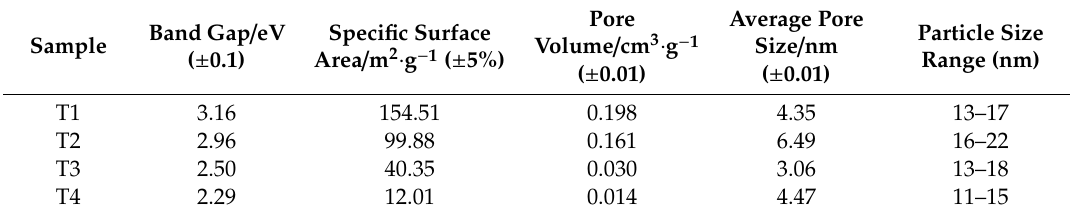
Table 2. Properties of the colored TiO 2 nanoparticles synthesized at various glycerol concentrations and calcined at 300 ◦